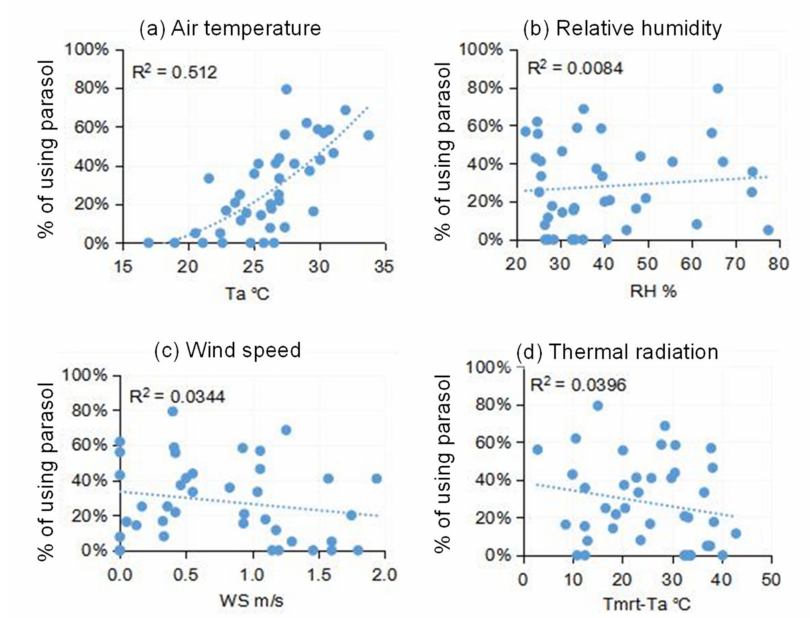
Figure 12. Percentage of women using parasols with respect to T a , RH , WS , and T mrt − T a for: ( a ) Air temperature, ( b ) Relative humidity, ( c ) Wind speed, and ( d ) Thermal